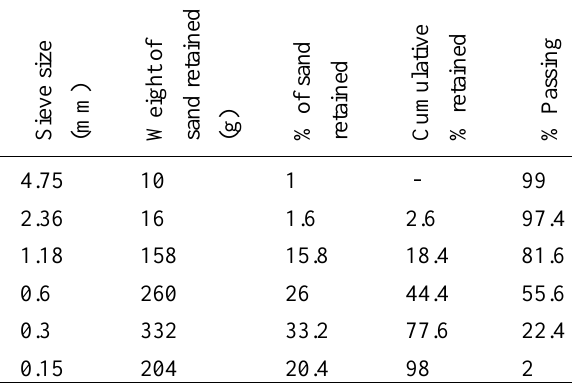
Sieve analysis of fine aggregate